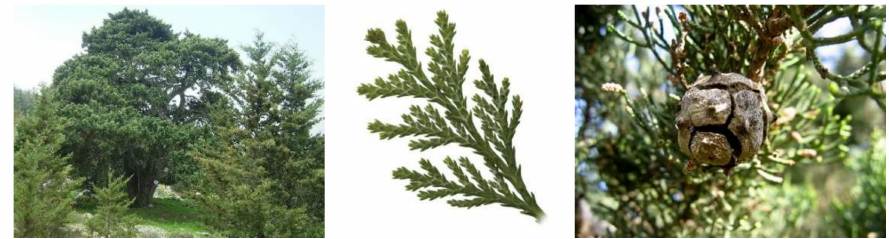
Figure 1. Particulars of the morphological features of Cupressus